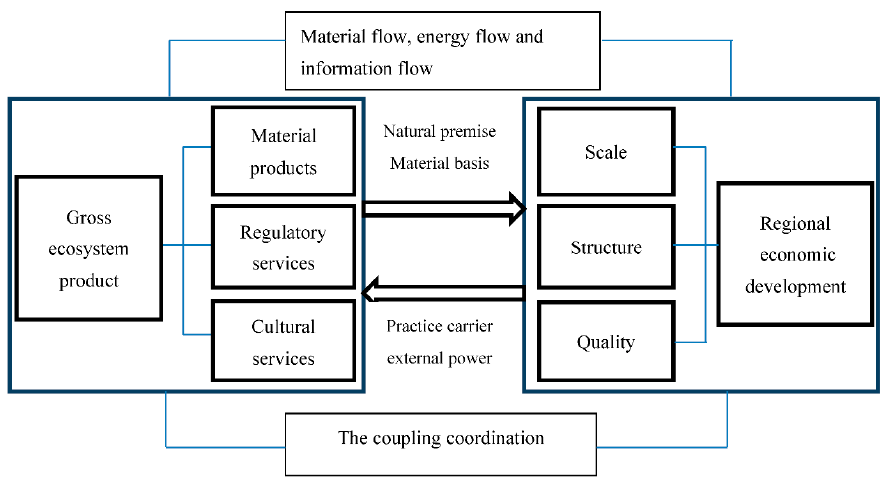
Figure 1. Coupling and coordination mechanism of GEP and regional economic development.